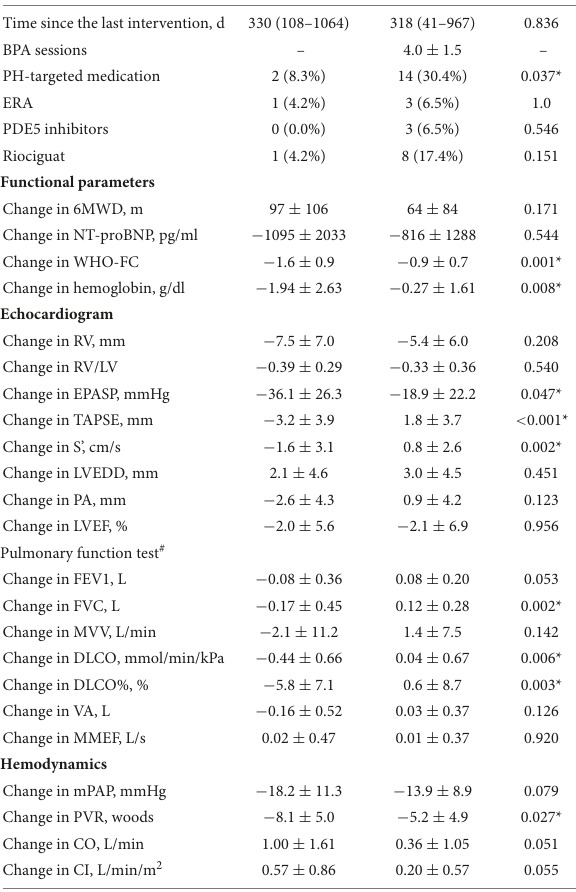
TABLE 3 Comparison between the PEA and BPA groups after